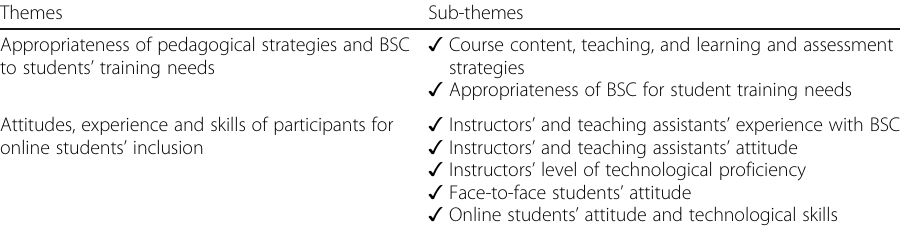
Table 2 Results for the features fostering academic integration and social integration in BSC in the MTP